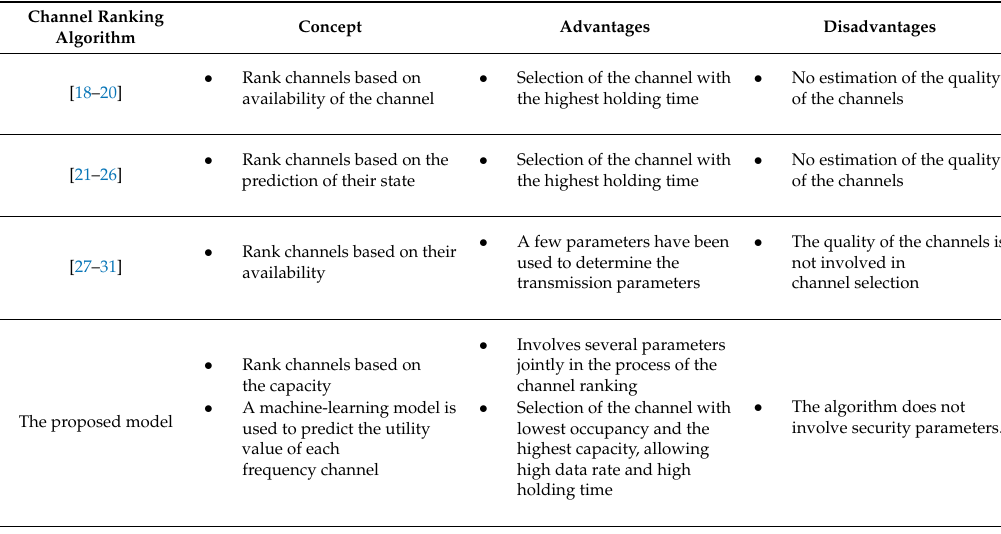
Table 4. Comparison of channel-ranking algorithms in cognitive radio